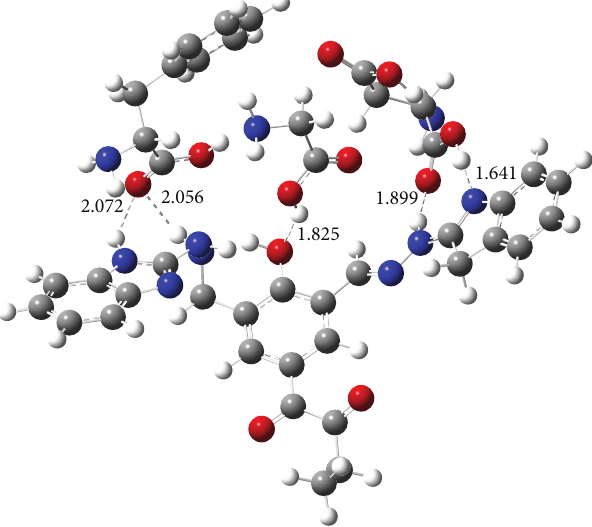
Figure 9: Optimized structure of Ligand 19- amino acids at M06/6-31g(d) level in gas phase. The hydrogen bond lengths (˚A) are noted.